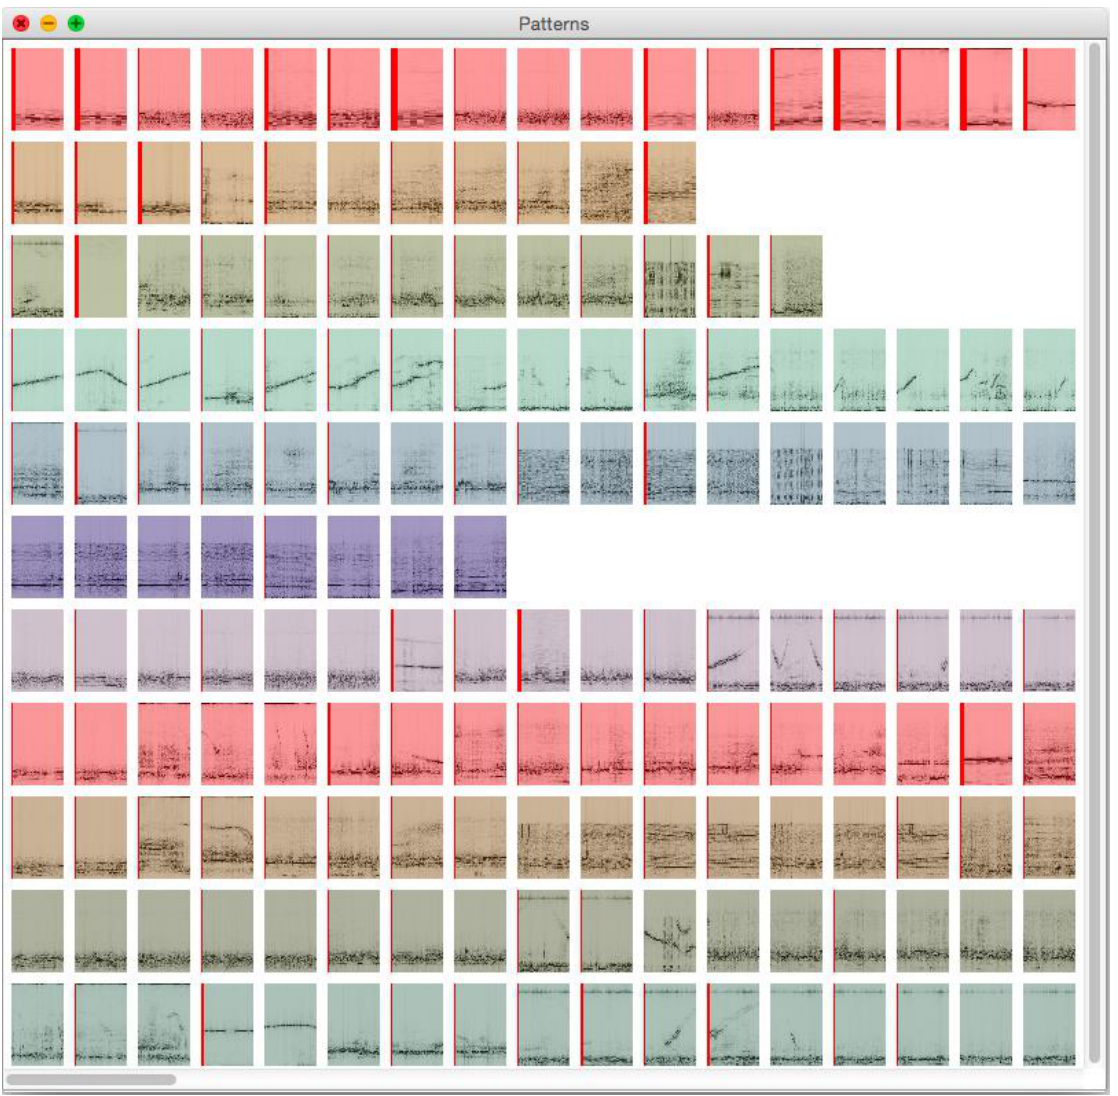
Figure 17. The pattern view in the signal imager for the exact discovery in the large dataset. Each row represents one pattern. Each column represents an example of that pattern. All examples are color-coded indicating the